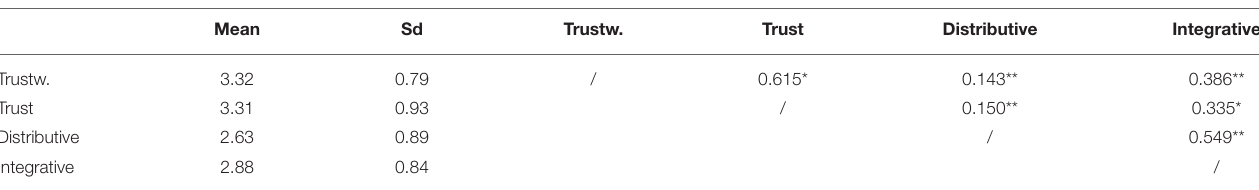
TABLE 2 | Descriptives and correlation analysis between examined variables ( N = 614). Mean Sd